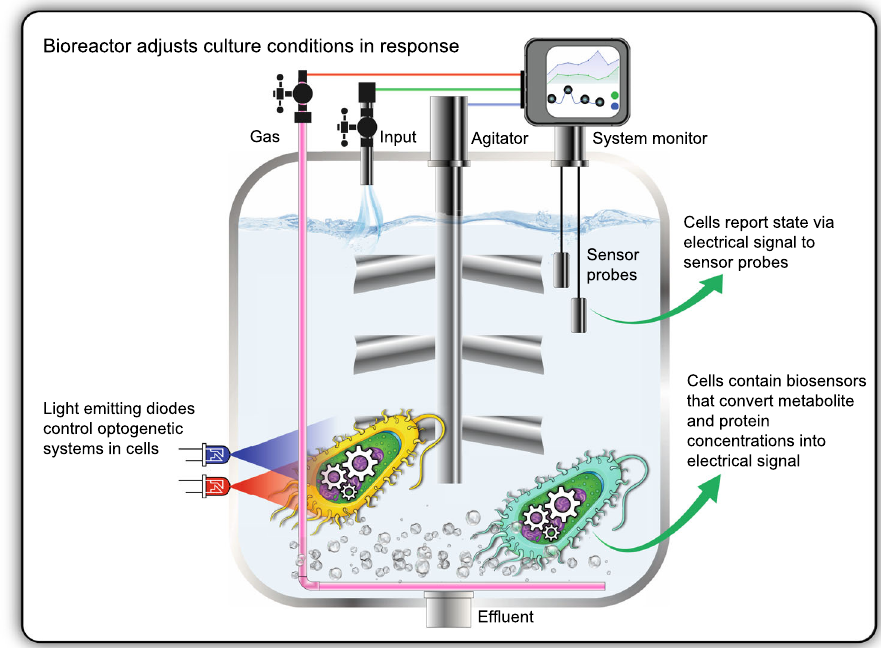
Fig. 3 An autonomous bioreactor enabling smart culture condition control and the targeted actuation of engineered gene expression without human intervention. Bio-informational systems involving optogenetic control of gene expression and biosensor-mediated output of intracellular physiological states could be integrated within a bioreactor to facilitate high-yield production of sustainable chemicals, fuels, foods, materials, and pharmaceuticals using microbial cell